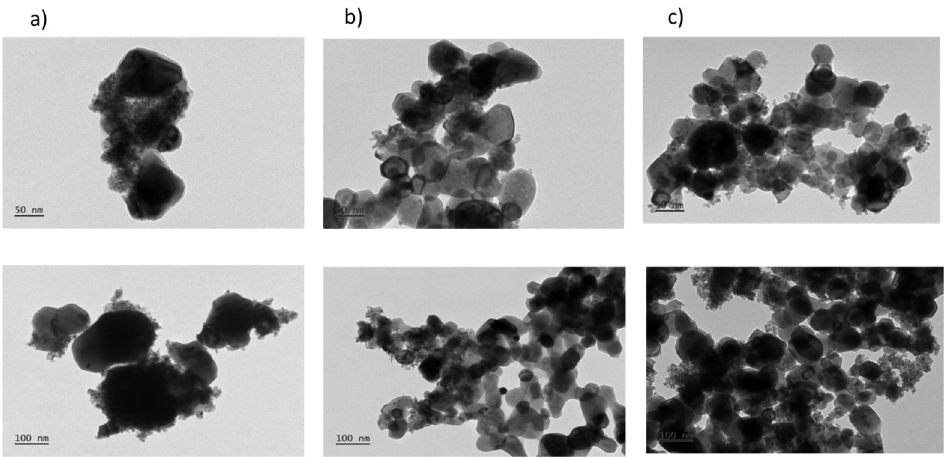
Figure 4. TEM images of ( a ) 15Ni/CeO 2 ; ( b ) 1Co15Ni/CeO 2 ; ( c ) 5Co15Ni/CeO 2 with different scales after reduction.